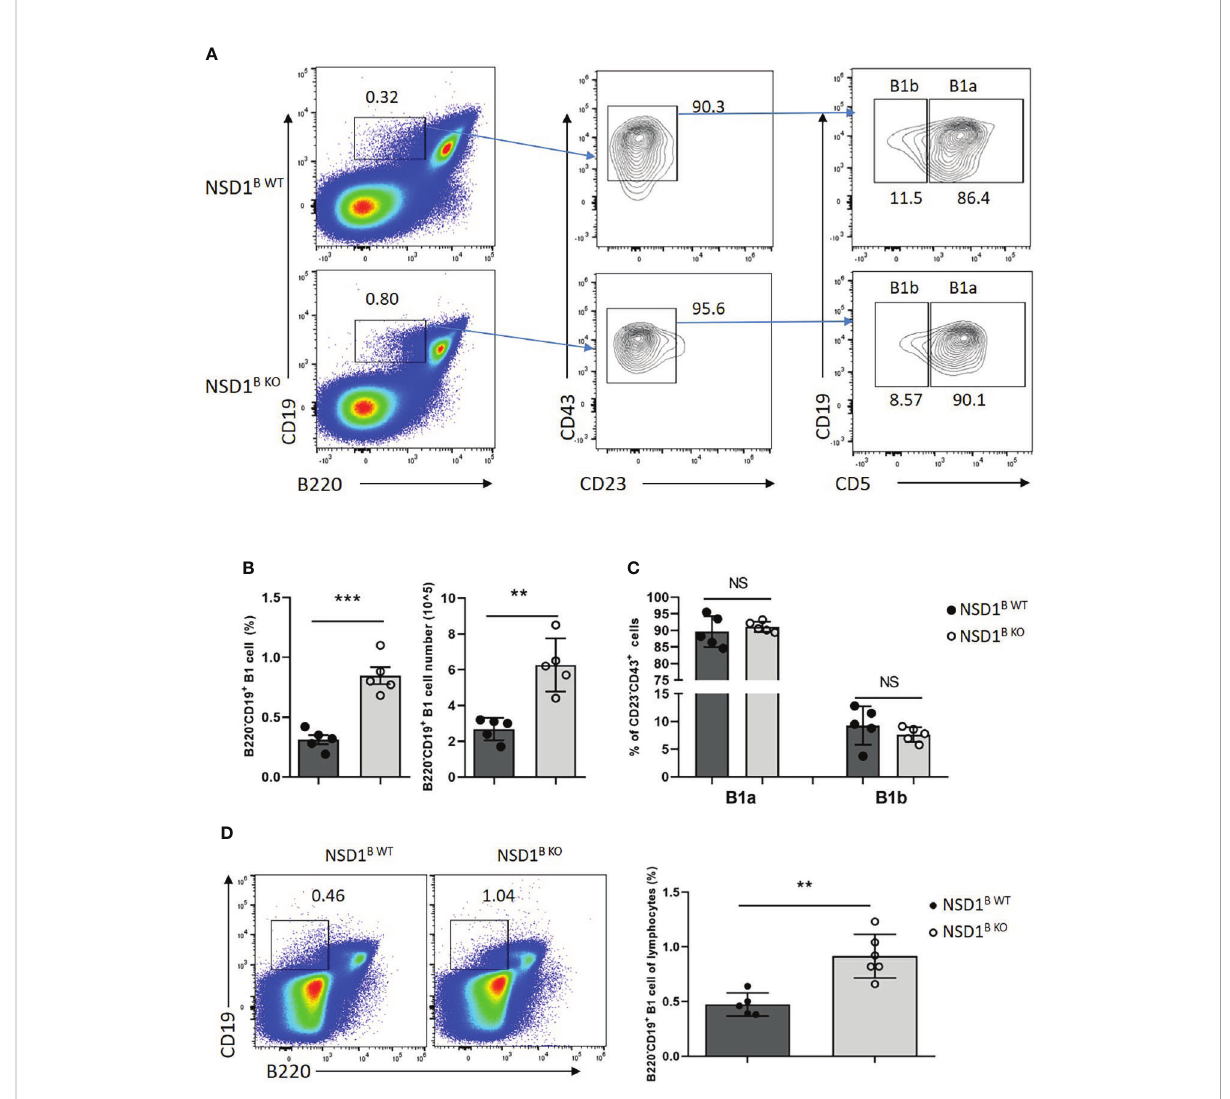
FIGURE 4 NSD1 de fi ciency promoted the development of B1 cells in spleen (A-C) . B1 cells (B220 + CD19 - ), B1a (B220 + CD19 - CD43 + CD23 - CD5 + ) and B1b (B220 + CD19 - CD43 + CD23 - CD5 - ) in the spleen from NSD1 B WT and NSD1 B KO mice. (n = 5). (D) . B1 cells (B220 + CD19 - ) in the spleen from one week old NSD1 B WT and NSD1 B KO mice. (n = 5 or 6). ** P < 0.01, *** P < 0.001. NS, no signi fi cant